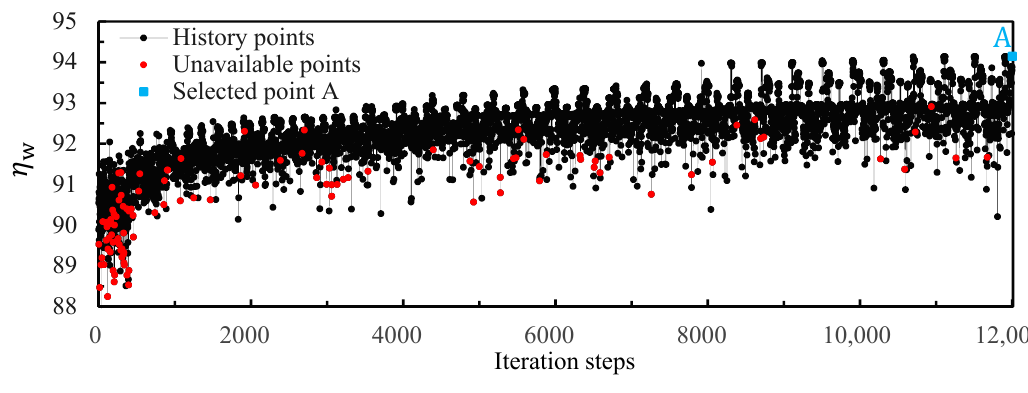
Figure 8. Optimization results of the first step. Table 4. Performance comparison between computational fluid dynamics (CFD) calculation and response surface method (RSM) prediction.